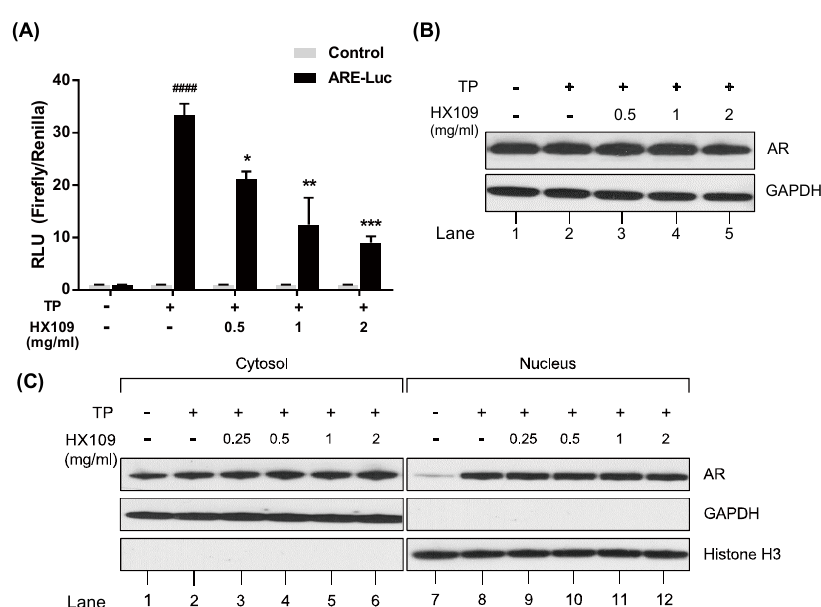
Figure 5. HX109 inhibited androgen receptor (AR) transcriptional activity without affecting AR expression and translocation. ( A ) Effects of HX109 on luciferase activity. LNCaP cells were transfected with control or luciferase reporter plasmid containing androgen receptor response element (ARE) sequence for 24 h. Transfected cells were treated with or without 100 nM TP in the presence of various concentrations of HX109 for 18 h. Luciferase activity was measured as described in the Materials and Methods section. #### p < 0.0001 (one-way ANOVA) compared with control, * p < 0.05, ** p < 0.001, *** p < 0.0001 (one-way ANOVA) compared with TP only. ( B ) The protein levels of AR were analyzed by western blot after 24 h treatment with HX109. ( C ) Effects of HX109 on AR translocation. LNCaP cells were treated with 100 nM TP in the presence of various concentrations of HX109 for 3 h. After treatment, nuclear and cytoplasmic extracts were collected and subjected to western blot. For western blot, three independent experiments were performed, and one representative result is presented here. All values are shown as mean ± S.E.M. of three independent experiments. ‘+’ means ‘treated with TP or HX109’, if it is on the right side of TP, it means ‘treated with TP’; if it is on the right side of HX109, it means ‘treated with HX109’. ‘ − ’ means ‘not treated with TP or